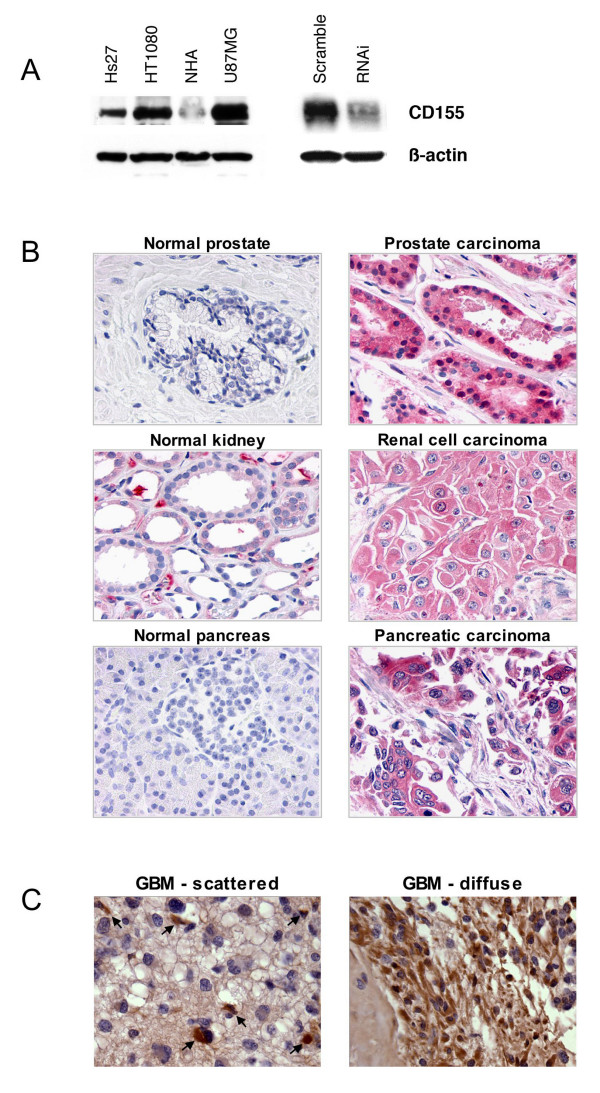
CD155 is highly expressed in cancer cells and primary tumors. (a) Lysates from normal and cancer-derived cell lines were immunoblotted for CD155. CD155 expression was elevated in fibrosarcoma cells (HT1080) vs. normal fibroblasts (Hs27) and also in glioblastoma cells (U87MG) vs. normal human astrocytes (NHA). Antibody specificity is demonstrated using HT1080 cells in which CD155 expression is knocked down by RNAi. β-actin is shown as a loading control. (b) CD155 protein expression was examined by immunocytochemistry across a panel of normal and cancer tissue samples. In normal tissue we observed moderate staining in kidney, plasma cells, liver, lung, theca interna of the ovary, and testis. No staining was observed in normal adrenal, bladder, brain, breast, colon, heart, pancreas, placenta, prostate, skin, skeletal muscle, small intestine epithelium, spleen, stomach, thymus, thyroid, or uterus. In cancer tissue, significant staining was observed in prostate, renal cell, and pancreatic carcinomas as well as in colon, non-small cell lung, ovarian, and breast carcinomas. (c) High CD155 protein expression was also observed in glioblastoma tumor tissue. Two types of staining were evident: scattered positive cells (arrows) in a primarily negative sample, or diffuse staining across many cells in a sample.